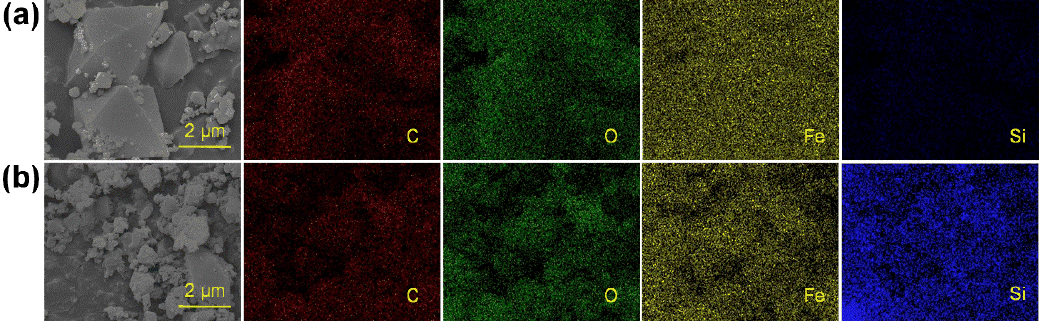
Figure 9. SEM image and elemental mapping of MIL-101(Fe) before ( a ) and after ( b ) adsorption of silicic acid. silicic